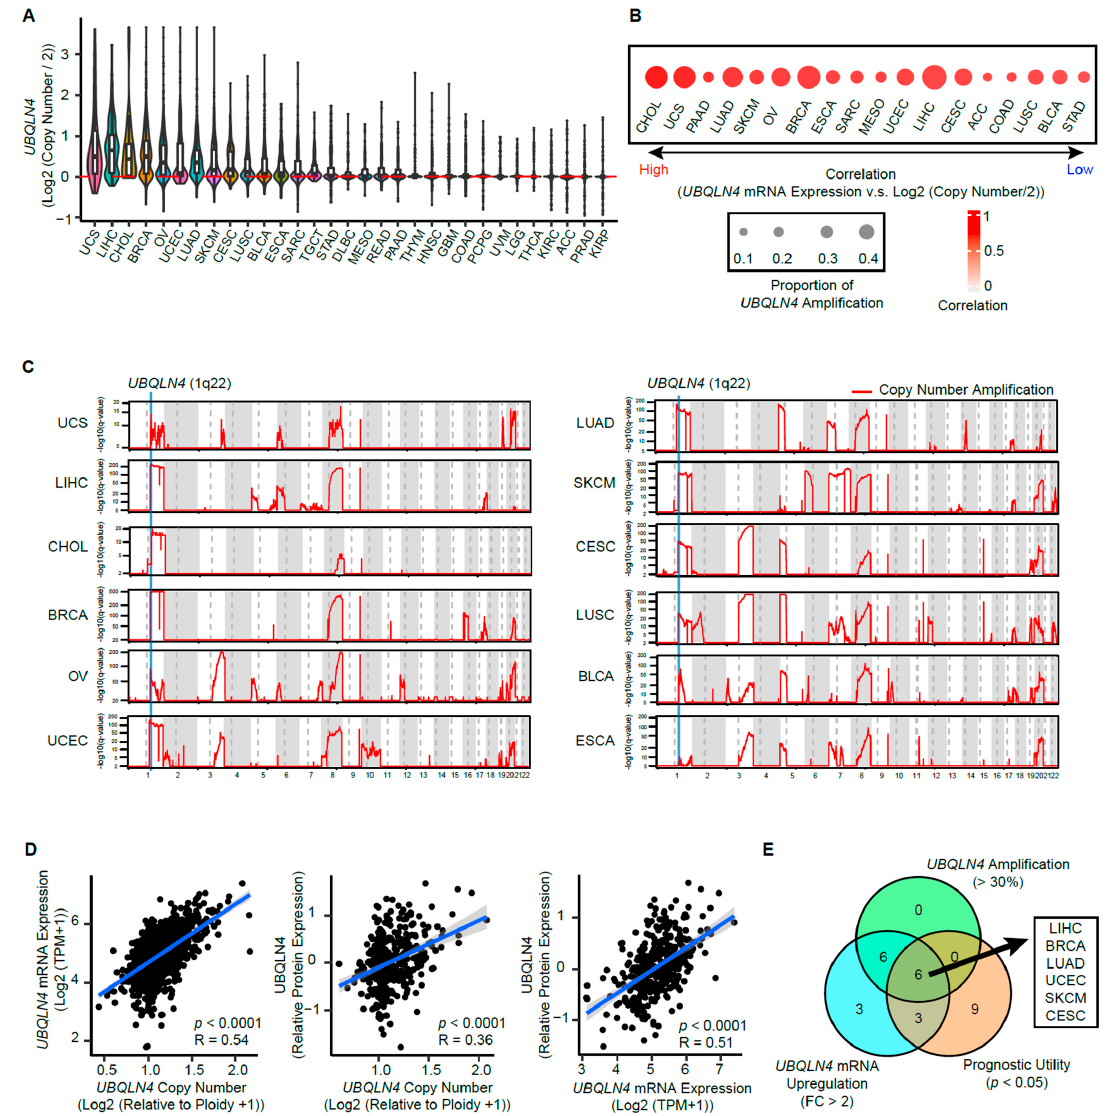
Figure 2. UBQLN4 showed genomic amplification in various types of solid tumors. ( A ) The dis- tribution of UBQLN4 DNA copy number in different types of cancer in TCGA. ( B ) The correlation between UBQLN4 mRNA expression, DNA copy number, and the proportion of UBQLN4 amplified samples in TCGA. Samples with the values of log2 (copy number/2) larger than 0.3 are categorized as amplified samples. Sizes of dots represent the proportion of amplified samples, while colors of dots represent the Pearson correlation coefficient between mRNA expression and DNA CNA of UBQLN4 . ( C ) Chromosomal regions are significantly affected by copy number amplifications (CNA). Statistical significance for recurrence of CNAs was evaluated by PART analysis. Blue lines indicate the chromosomal region of UBQLN4 in the 1q22 chromosomal region. ( D ) Pearson’s correlation between DNA copy number, mRNA expression, and protein expression of UBQLN4 of pan-cancer cell lines in the CCLE datasets. ( E ) Integration of UBQLN4 analysis. Each number indicates the number of cancer types satisfying each